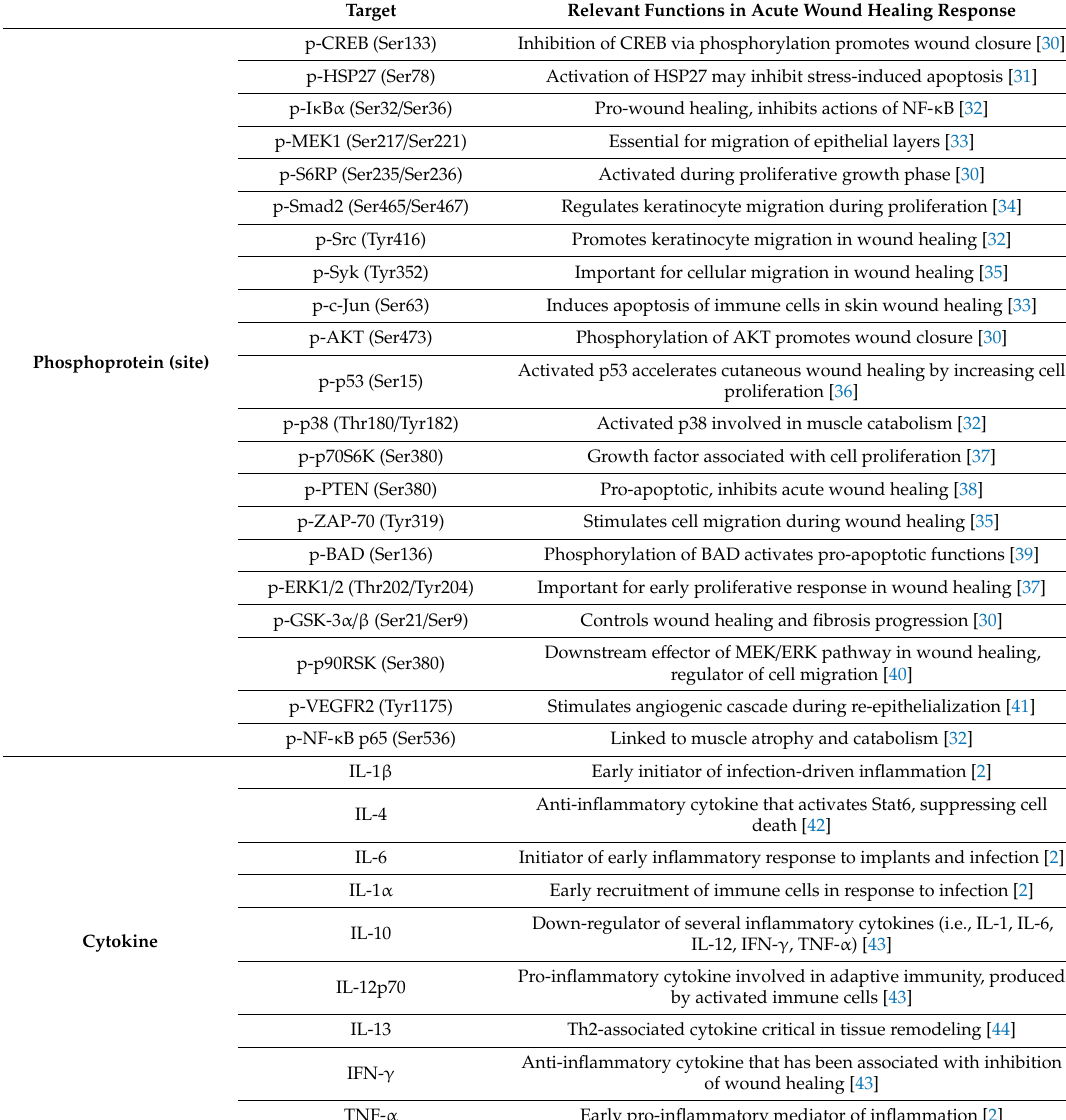
Table 2. Cytokines and Phosphoprotein Targets Measured in Tissue Samples. Citations are noted in